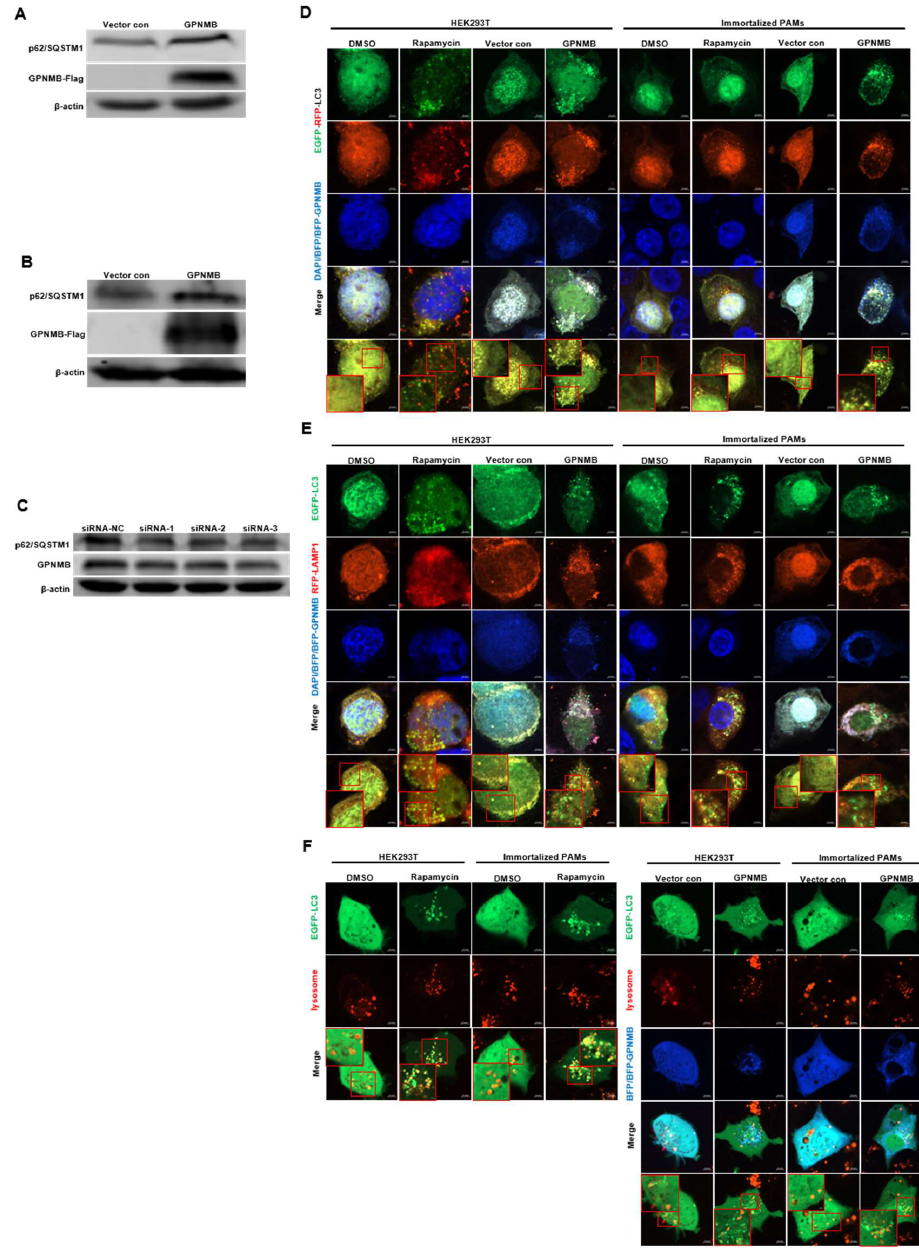
Figure 5. Autophagosomes do not fuse with lysosomes in GPNMB-overexpressed cells efficiently. ( A , B ) HEK293T cells ( A ) and immortalized PAMs ( B ) were transfected with GPNMB-Flag and then harvested and lysed. Extracts were analyzed by Western blot using an anti-p62/SQSTM1 antibody. ( C ) Immortalized PAMs were transfected with siRNA-GPNMB or siRNA-NC for 24 h, and then harvested and lysed. Extracts were analyzed by Western blot using an anti-p62/SQSTM1 antibody. ( D ) The colocalization analysis of HEK293T cells and immortalized PAMs overexpressed with BFP-GPNMB after transfected EGFP-RFP-LC3, treatment with rapamycin induced autophagy as a positive control. ( E ) The colocalization analysis of EGFP-LC3 with RFP-LAMP1 in GPNMB-overexpressed HEK293T cells and immortalized PAMs, treatment with rapamycin induced autophagy as a positive control. ( F ) Live cell imaging was performed to analyze colocalization of LysoTracker-stained acidified vesicles and EGFP-LC3-positive autophagosomes in GPNMB-overexpressed HEK293T cells and immortalized PAMs, treatment with rapamycin induced autophagy as a positive control. The red box indicates the regions where image was